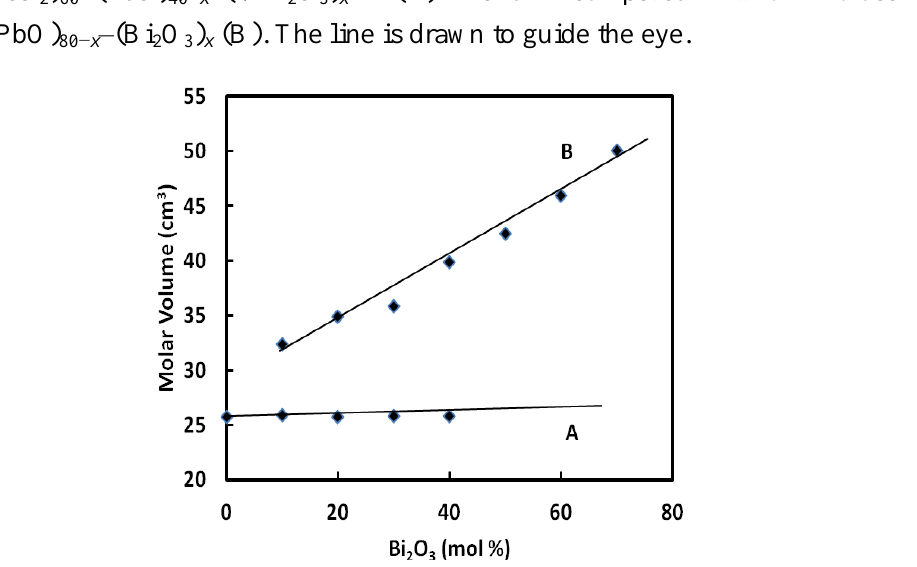
Figure 2. Molar volume of the ternary lead-bismuth germinate glasses of the form (GeO